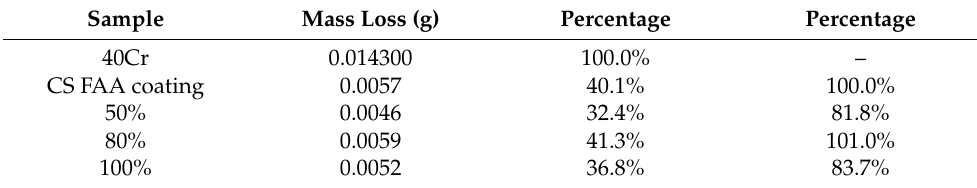
Table 4. Mass loss of the CS and laser re-melted CS FAA coatings after wear test